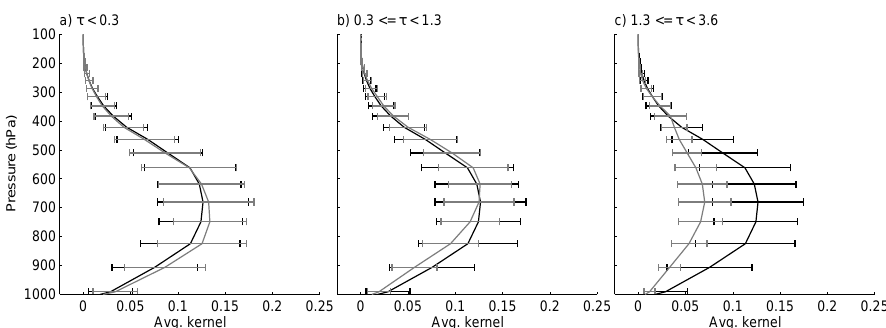
Fig. 6. HDO averaging kernel rows (grey) at 618hPa for CTP less than 440hPa and for τ (a) less than 0.3 (b) between 0.3 and 1.3 (c) between 1.3 and 3.6. Black profiles show the grand mean HDO averaging kernel row at 618hPa across all high quality retrievals. Error bars show the standard deviation at each level. These averaging kernels correspond to the first three entries in the top row of Table 4.